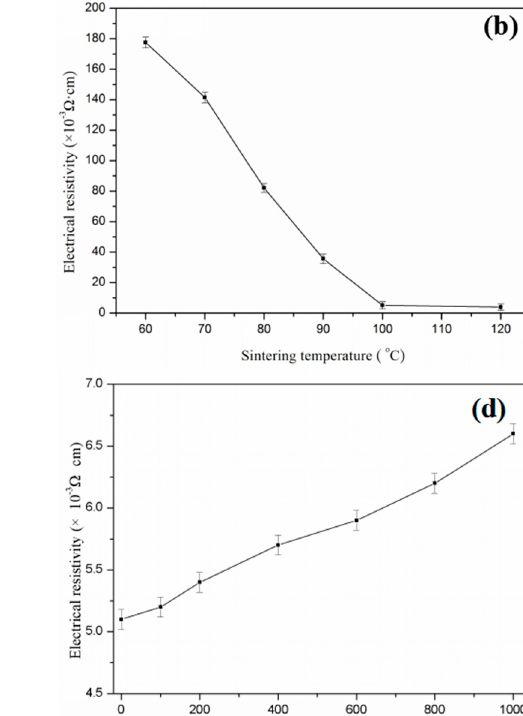
Figure 9. The resistivity of the printed Ag patterns with: ( a ) different printing times; ( b ) different sintering temperature; ( c ) different sintering time; and ( d ) different bending times.